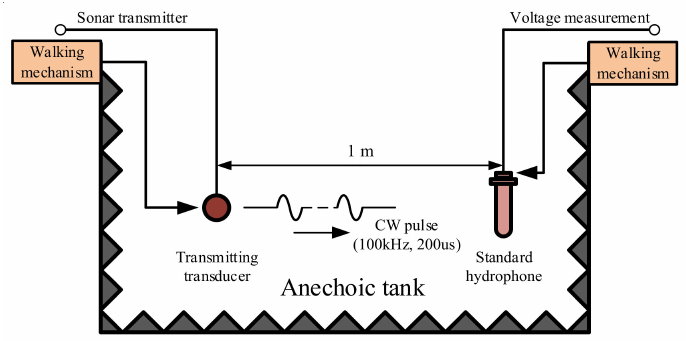
Figure 20. Schematic diagram of sound source level measurement.